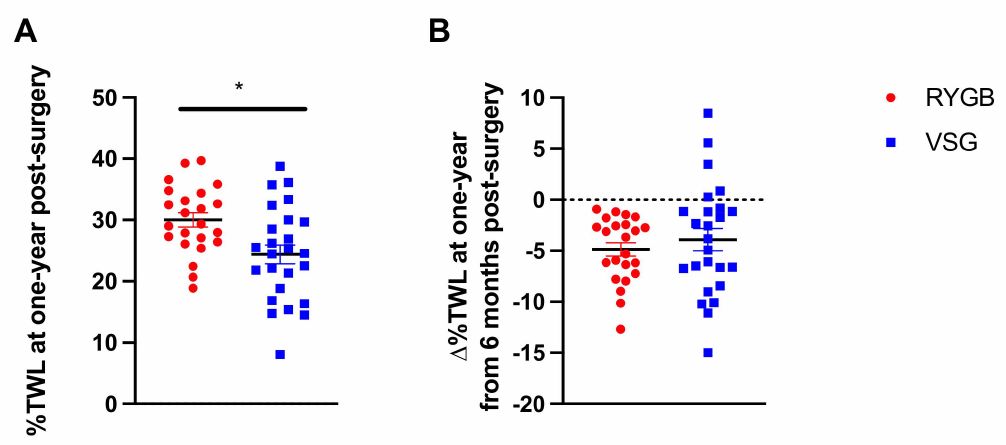
Figure 1. ( A ) Mean ± SEM (Standard Error of the Mean) %TWL (% Total Weight Loss) at one year following RYGB (Roux-en-Y Gastric Bypass; red circles) and VSG (Vertical Sleeve Gastrectomy; blue squares). ( B ) Mean ± SEM ∆ %TWL from six months to one year following RYGB (red circles) and VSG (blue squares), where positive values indicate weight gain and negative values indicate weight loss. * p < 0.05.